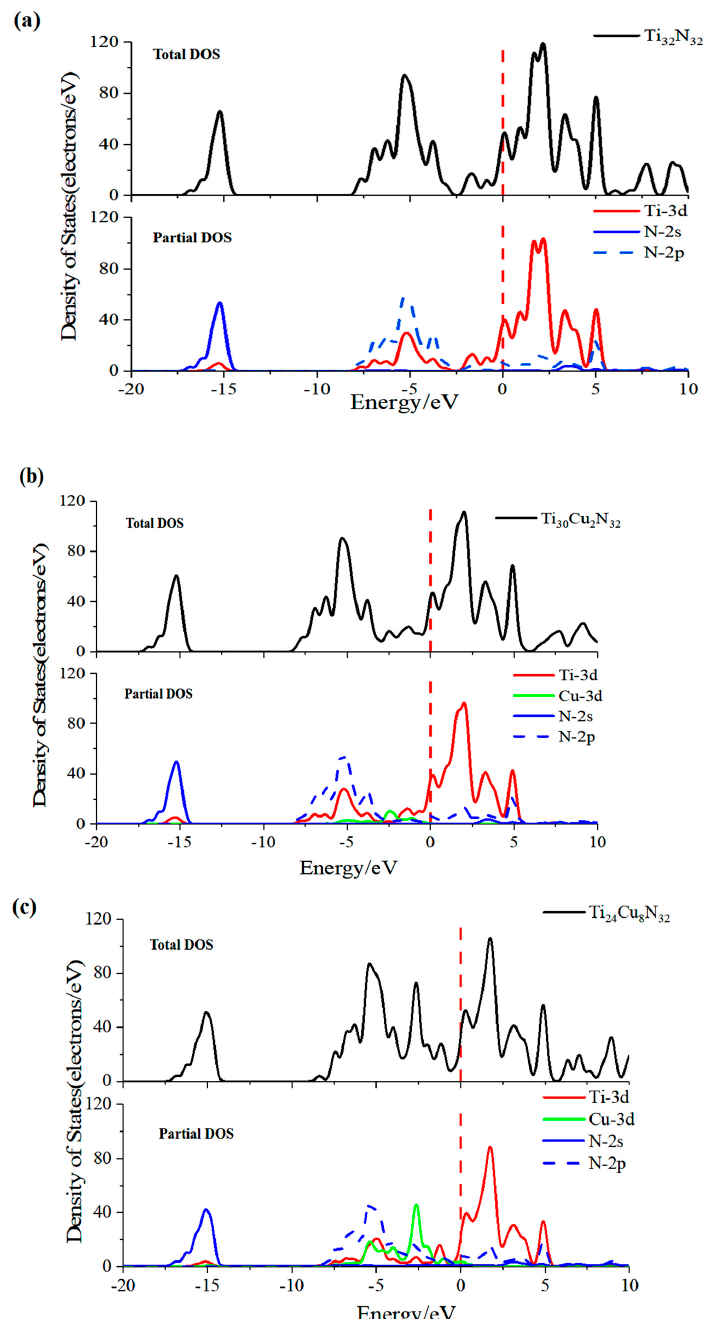
Figure 9. Typical total density of states and partial density of states for ( a ) Ti 32 N 32 ; ( b ) Ti 30 Cu 2 N 32 ; and ( c ) Ti 24 Cu 8 N 32 .